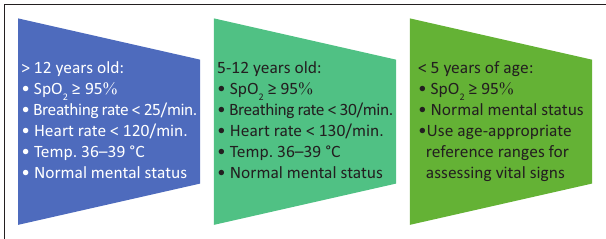
FIGURE 4: The criteria for mild COVID-19 according to the latest NDoH/NICD guidelines. 14